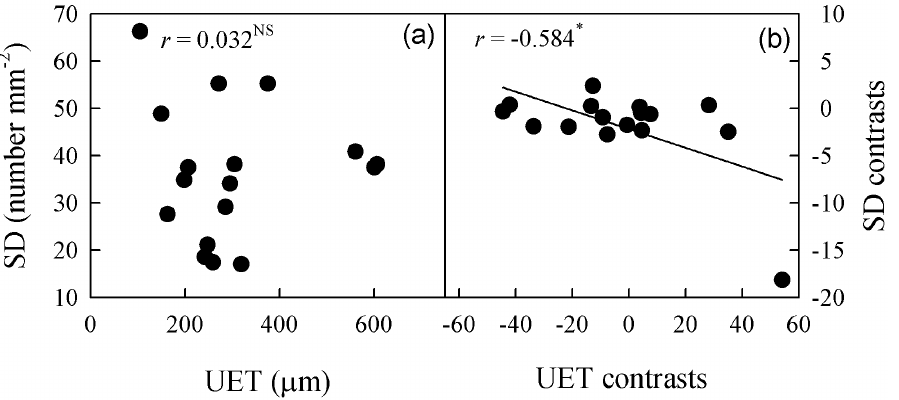
Figure 6. Correlation of upper epidermal thickness (UET) with stomatal density (SD). (a) Pearson’s regression, and (b) phylogenetically independent contrast correlation.